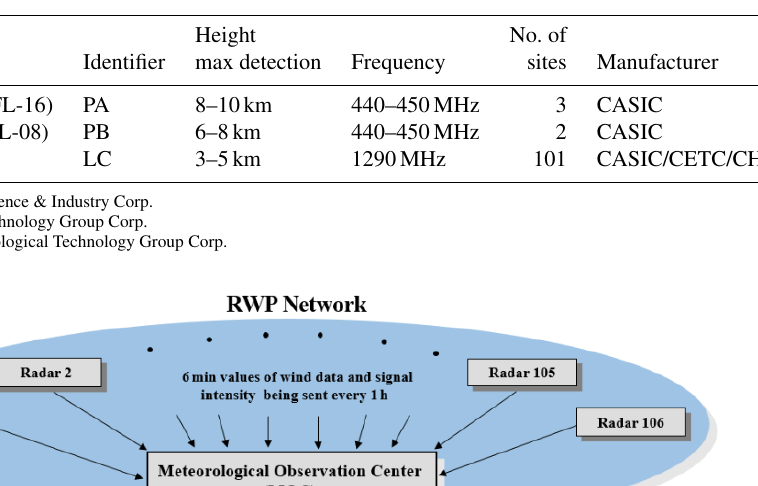
Table 1. Instrument information of the radar wind profiler network of China.